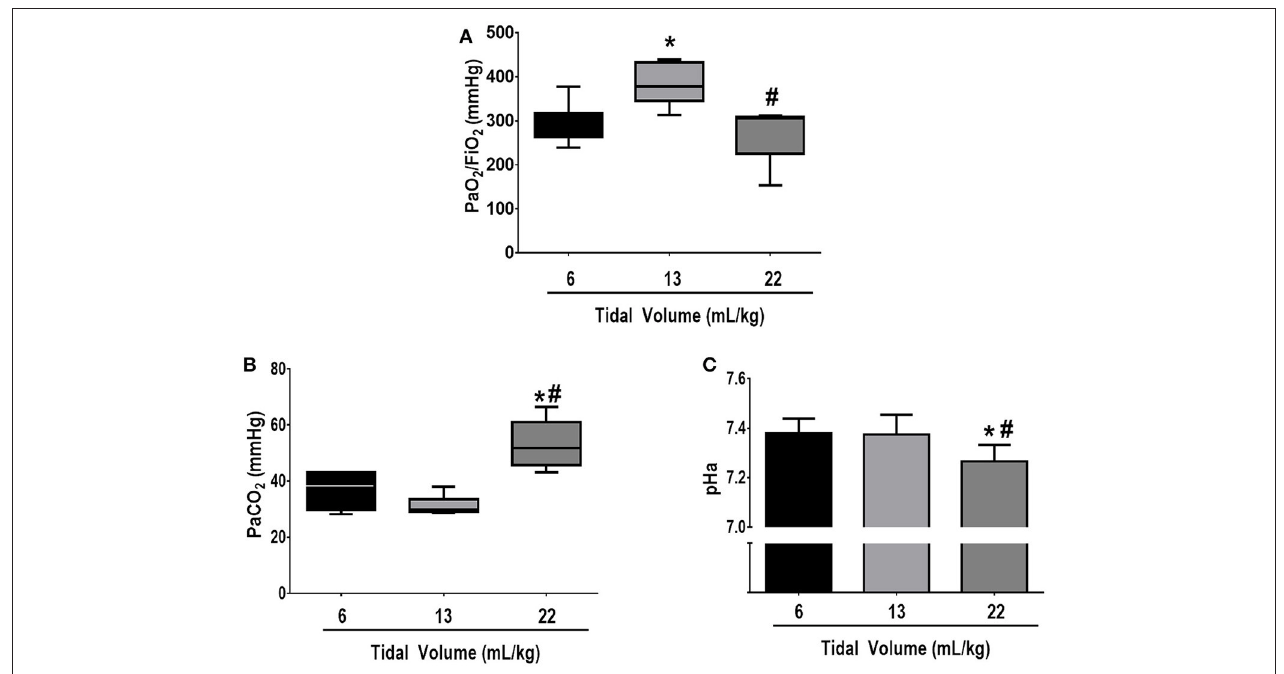
FIGURE 2 | (A) PaO 2 /FiO 2 , (B) PaCO 2 , and (C ) arterial pH at FINAL. The following groups were analyzed: (1) V T = 6 mL/kg and RR adjusted to normocapnia; (2) V T = 13 mL/kg; (3) V T = 22 mL/kg. In the second and third groups, RR was adjusted to yield mechanical power comparable to that in the first group. PaO 2 /FiO 2 and PaCO 2 values are medians and interquartile ranges of 7 rats in each group. pH values are mean (SD) of 7 animals/group. *vs. 6mL/kg ( p < 0.05); # vs. 13 mL/kg ( p <